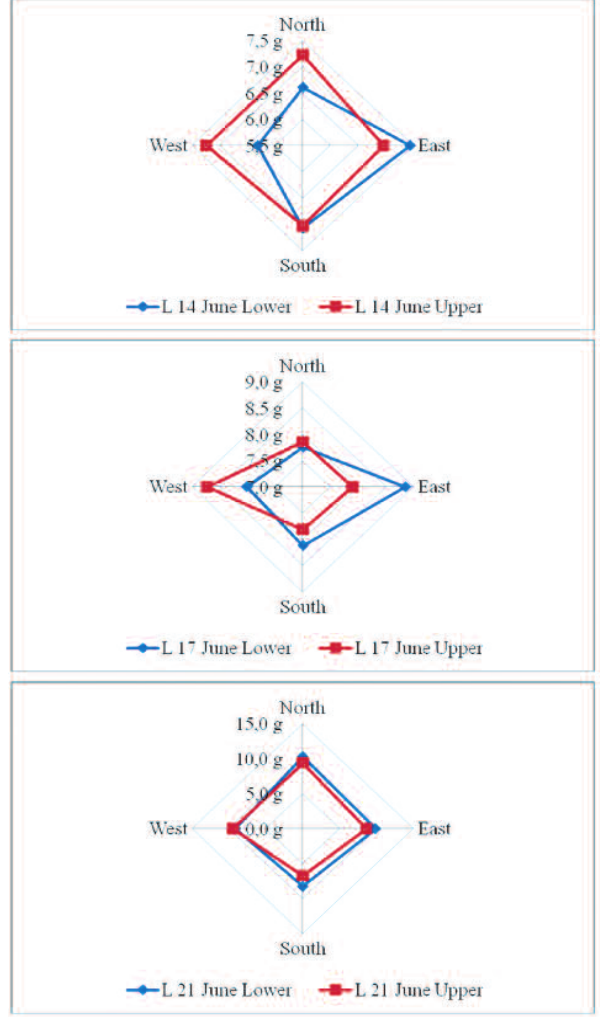
Fig. 6: The mass in the function of time, orientation and height In the case of